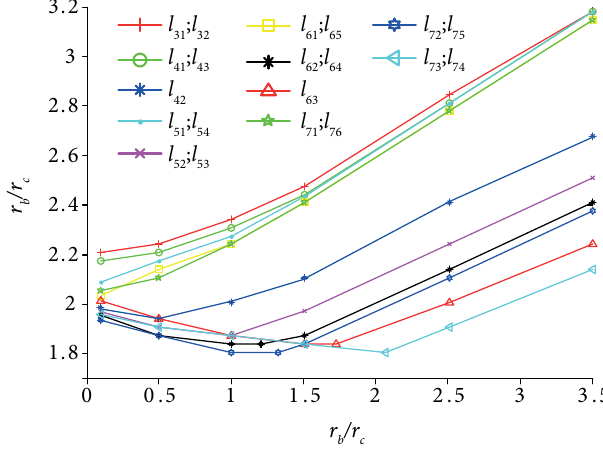
Figure 6. Peak line l